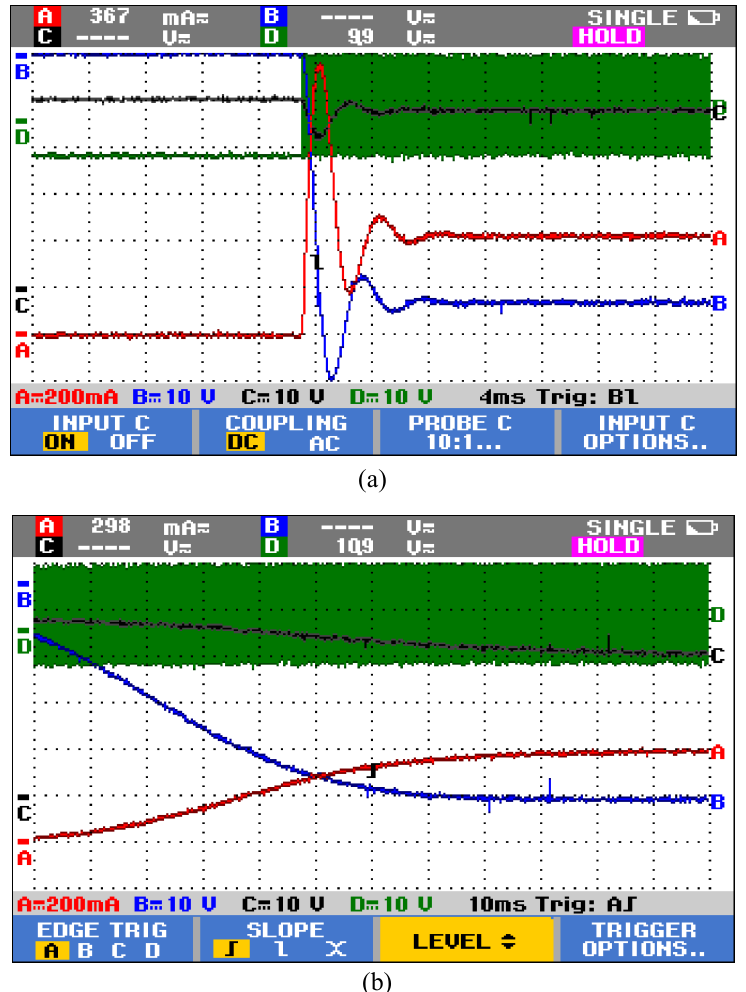
Figure 12. Experimentally measured response of the converter with PV source: ( a ) open-loop system and ( b ) closed-loop system, to the startup transient in the control variable, showing Ch A: source current with 1 V/5 A sensor gain and 200 mV/div, Ch B: converter output voltage 10 V/div, Ch